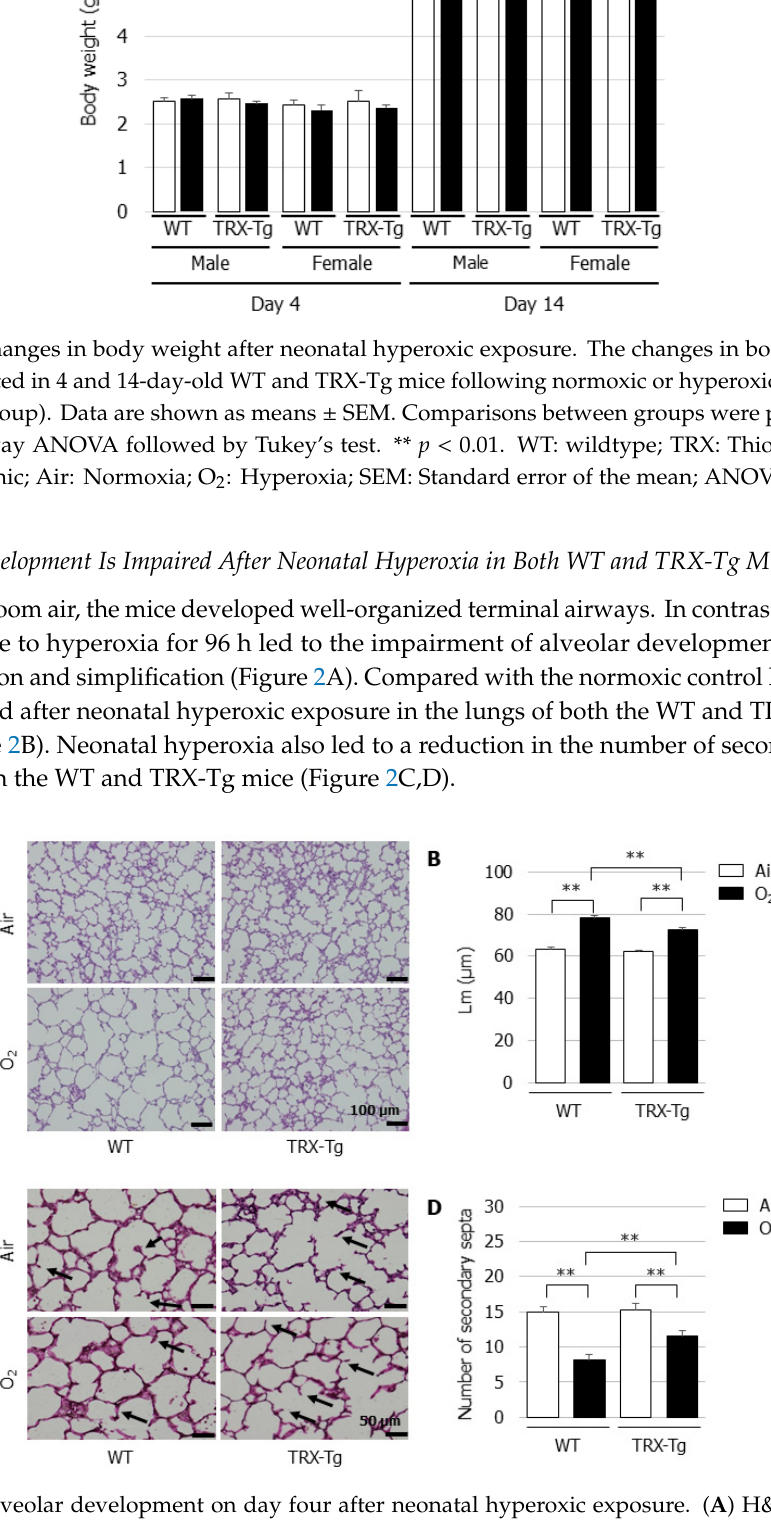
Figure 2. Alveolar development on day four after neonatal hyperoxic exposure. ( A ) H&E-stained histological sections. Scale bar = 100 µm (magnification × 100). ( B ) Lm ( n = 6 per group). Lm was assessed in six nonoverlapping fields of lung parenchyma in one tissue section per animal. Animals